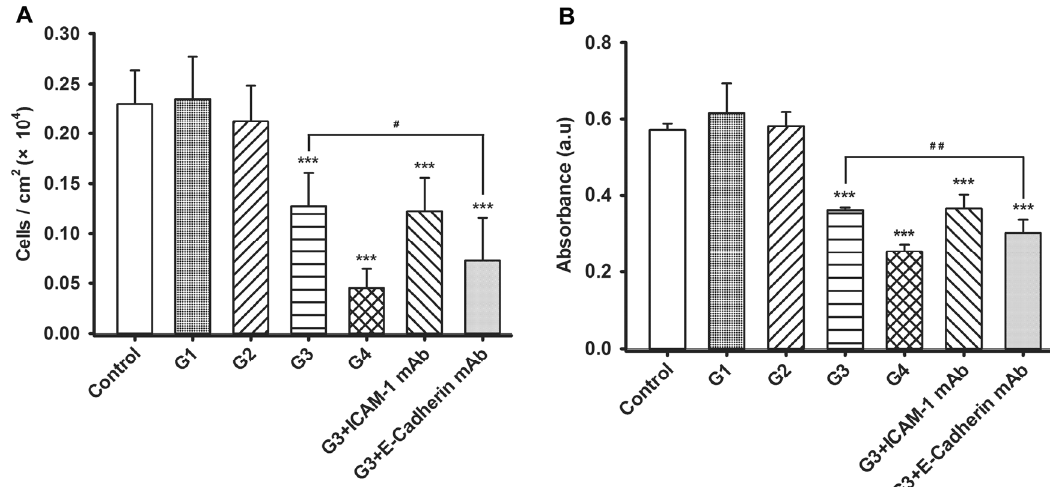
Figure 3. RSV-induced extracellular matrix (ECM) adherence of 16HBE cells progressively declines over the course of infection and is dependent on E-cadherin, but not ICAM-1. The adherent 16HBE cells to rat tail tendon collagen type I-coated plates was counted microscopically ( A ) or determined using crystal violet staining ( B ). Symbols signify statistical significance, where * p < 0.05, ** p < 0.01, and *** p < 0.001 compared with control (non-inoculated cells); # p < 0.05 and ## p < 0.01 compared with the